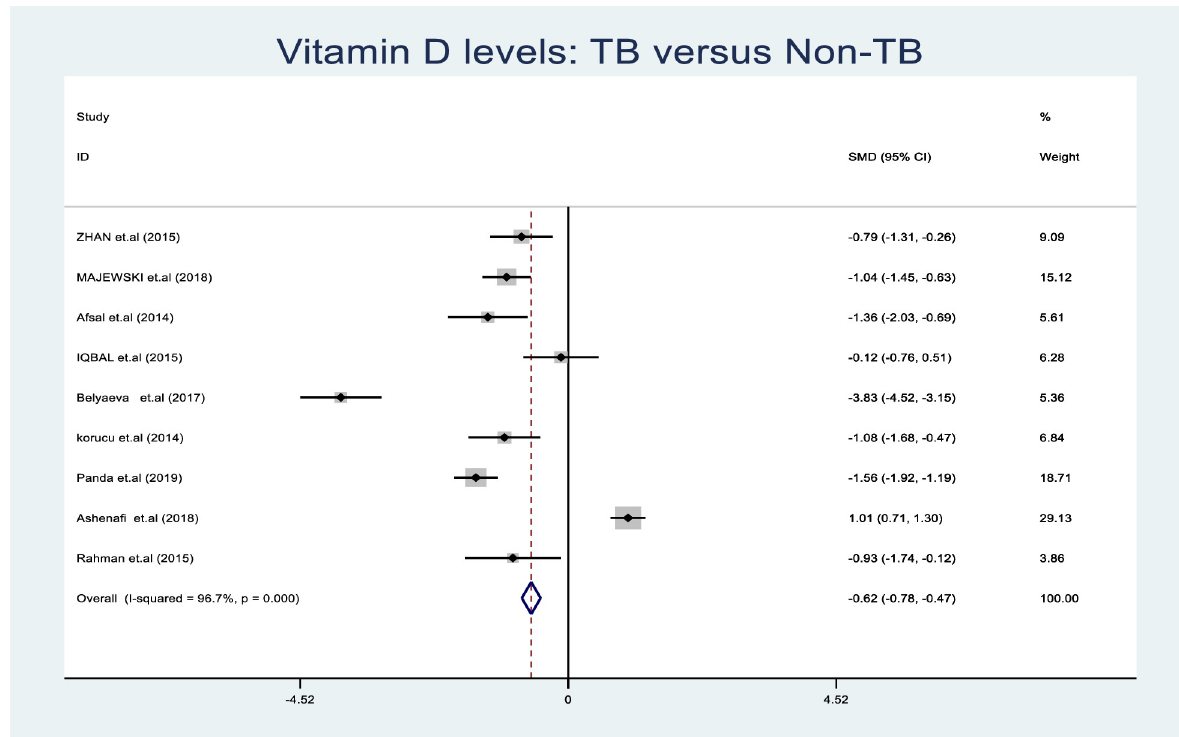
Fig 2. Forest plot showing the comparison of vitamin D levels among TB patients and non TB individuals: Overall effect of continuous variables using the random effect model. The solid vertical line represents no effect in SMD and the broken vertical line indicates the combined (overall) estimates while the diamond stands for the overall pooled SMD